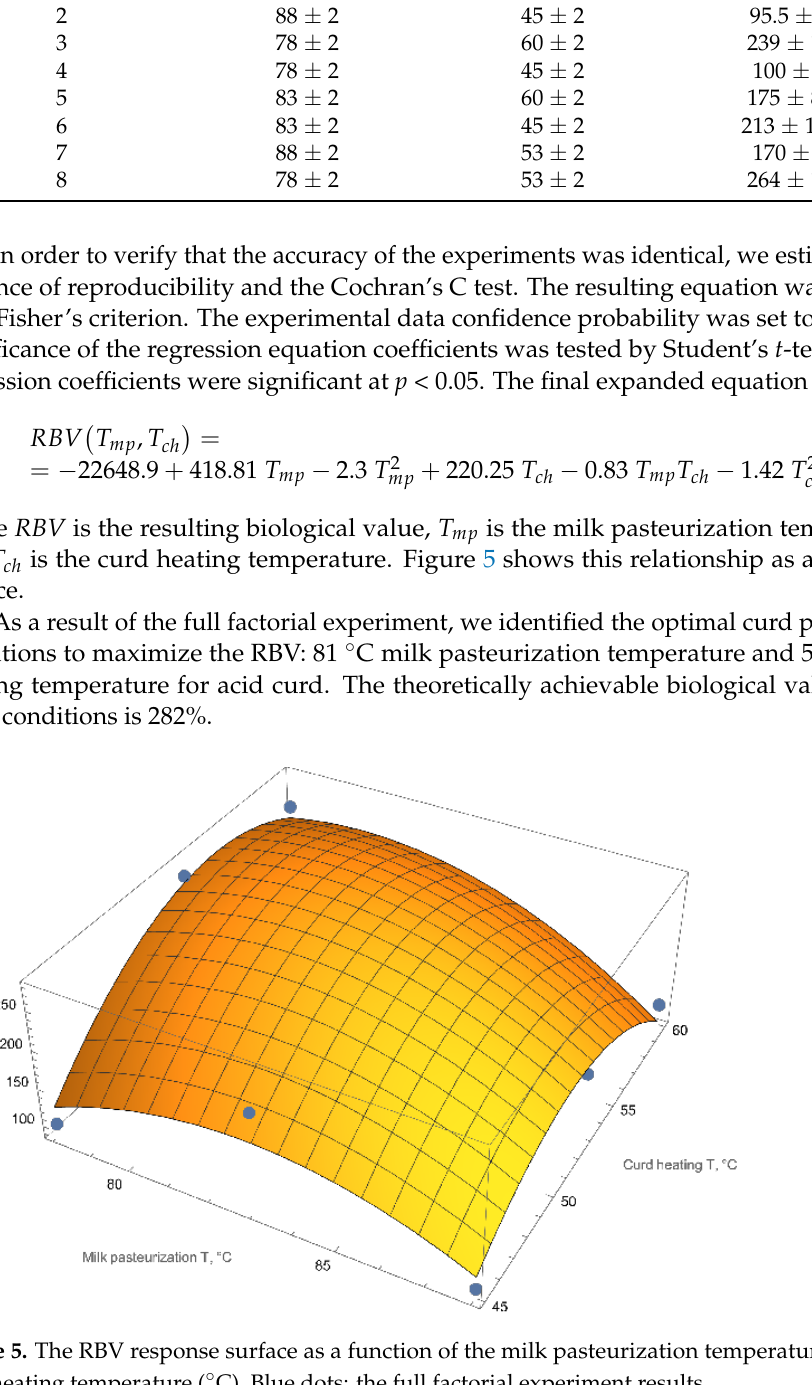
Table 7. Full factorial quadratic experiment design.